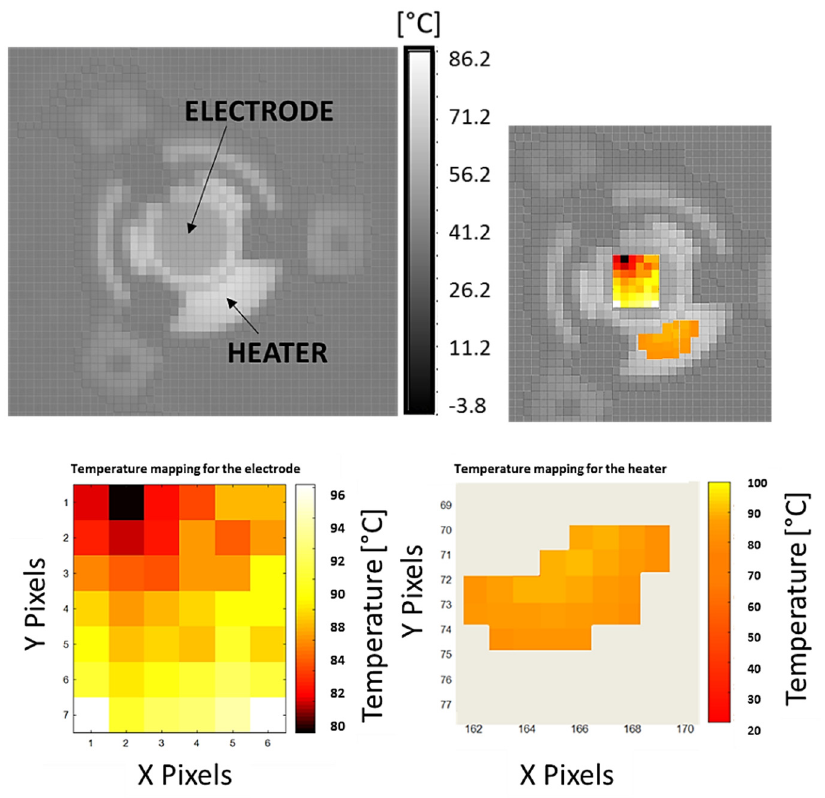
Figure 8. Temperature map and detailed views of the electrode and heater areas.